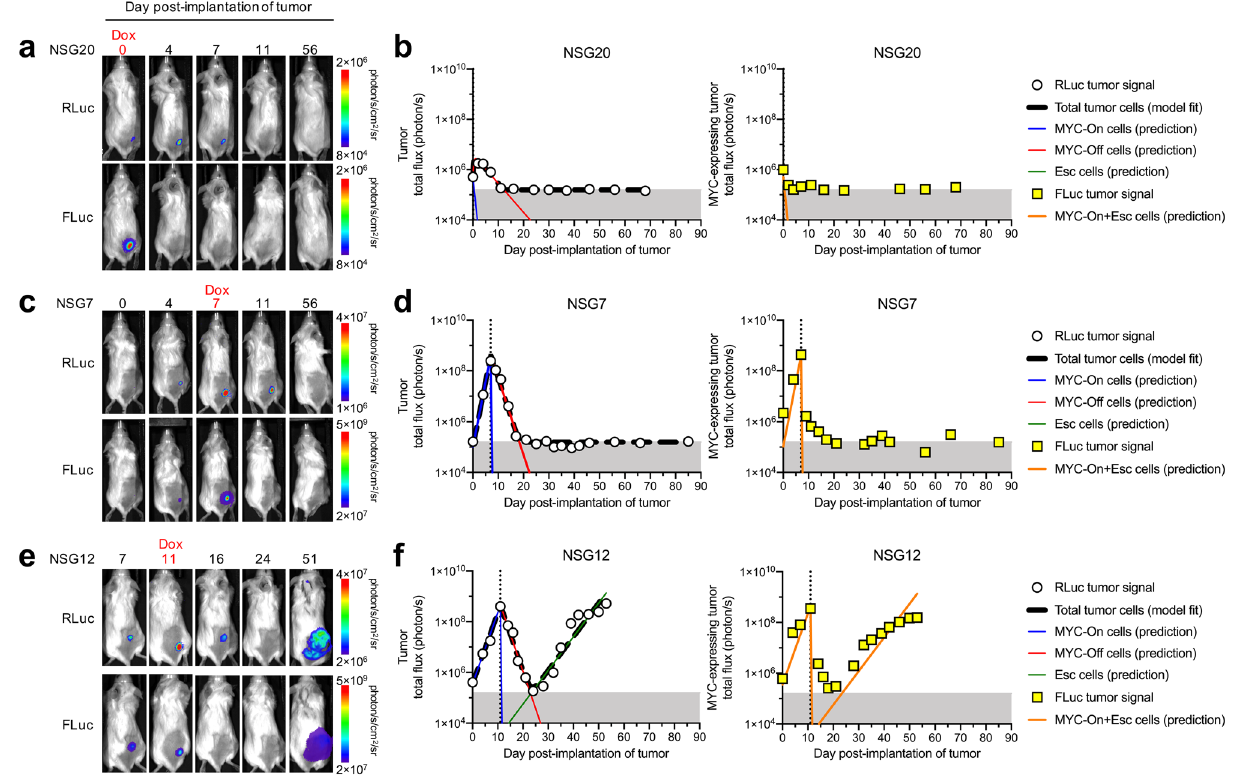
Figure 4. Bioluminescence imaging (BLI) of PGK-RLuc and Tet-FLuc signals in three representative NSG mice treated with doxycycline (Dox) on ( a , b ) day 0, ( c , d ) day 7, or ( e , f ) day 11 after tumor transplantation. ( b , d , f ) The simplified 3-compartment model was fitted (dashed black line) to RLuc signal (white circles), shown superimposed with the predicted population of MYC-On cells (blue line), MYC-Off cells (red line), and Escaped cells (green line). Shaded grey region (below 1.60 × 10 5 photon/s) indicates imaging signal is below the limit of detection. The model-predicted MYC-expressing tumor cell population (orange line) is shown superimposed with Tet-FLuc signal (yellow